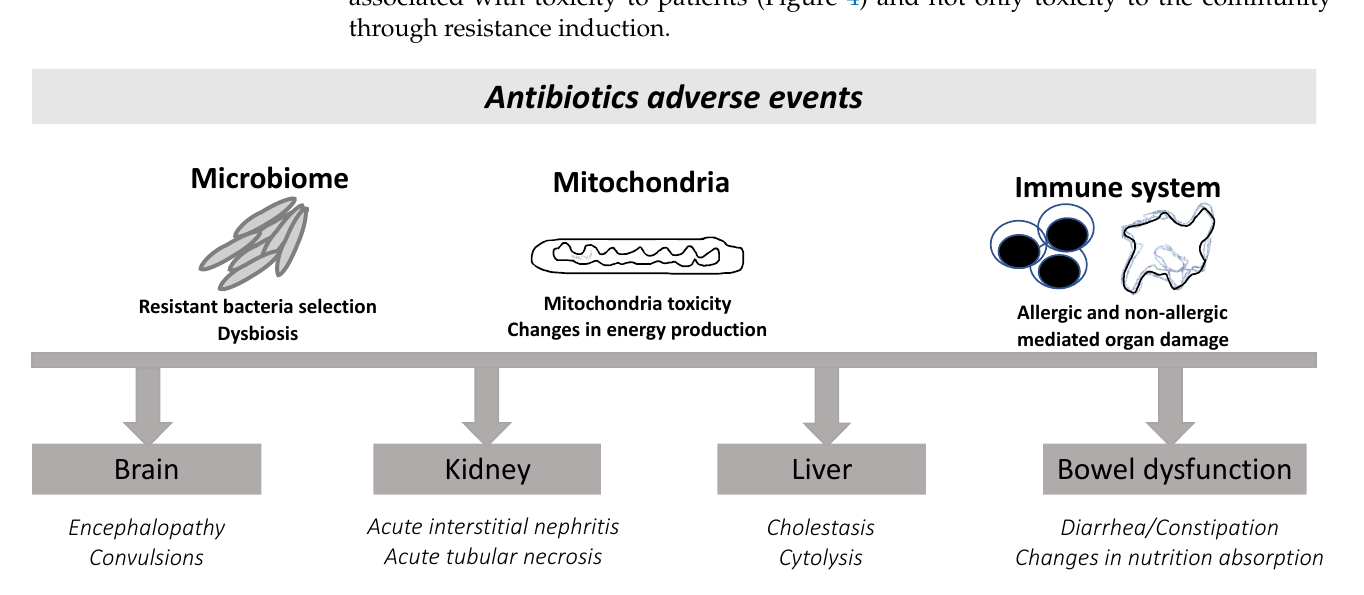
Figure 4. Antibiotic-related adverse events in patients.